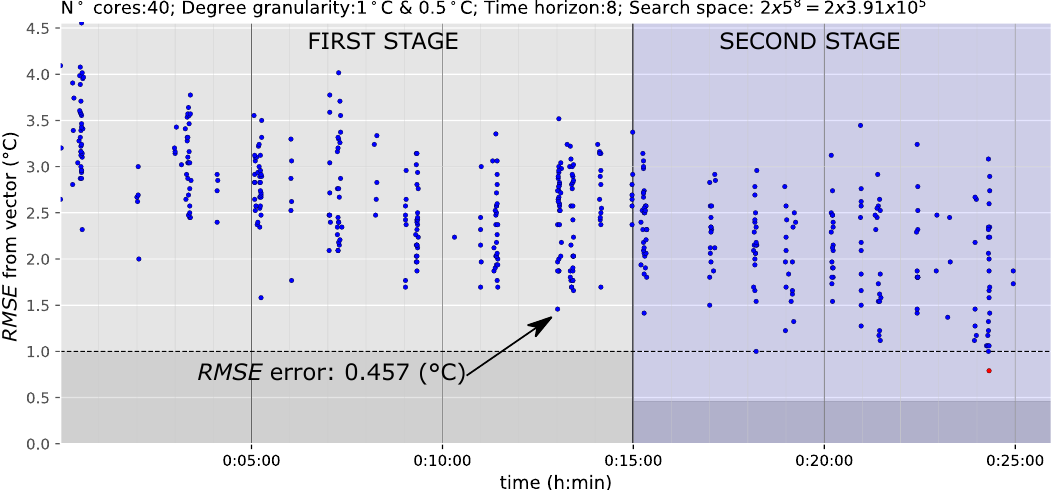
Figure 11. MPC results using two stages to obtain the MPC vector (8 h).